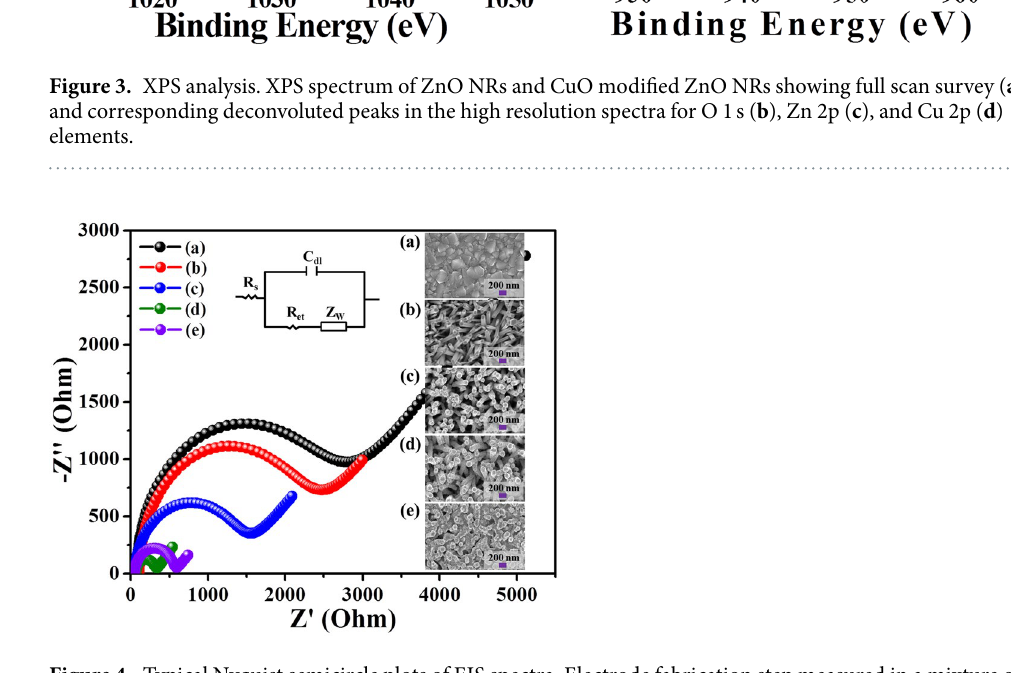
Figure 4. Typical Nyquist semicircle plots of EIS spectra. Electrode fabrication step measured in a mixture of 5 mM [Fe(CN) 6 ] 3-/4- and 0.1 M KCl solutions at an applied amplitude of ± 5 mV within a frequency range of 0.01 Hz-100 MHz. ( a ) Bare FTO electrode, ( b ) ZnO NRs/FTO electrode, ( c ) 10 s CuO modified ZnO NRs/FTO electrode, ( d ) 20 s CuO modified ZnO NRs/FTO electrode, and ( e ) 30 s CuO modified ZnO NRs/FTO electrode. Inset FESEM images show the surface morphology of the electrodes. Randles equivalent circuit model is shown in inset, where C dl , R s , R et , and Z w are double layer capacitor, solution resistor, electron transfer resistance, Warburg resistor,